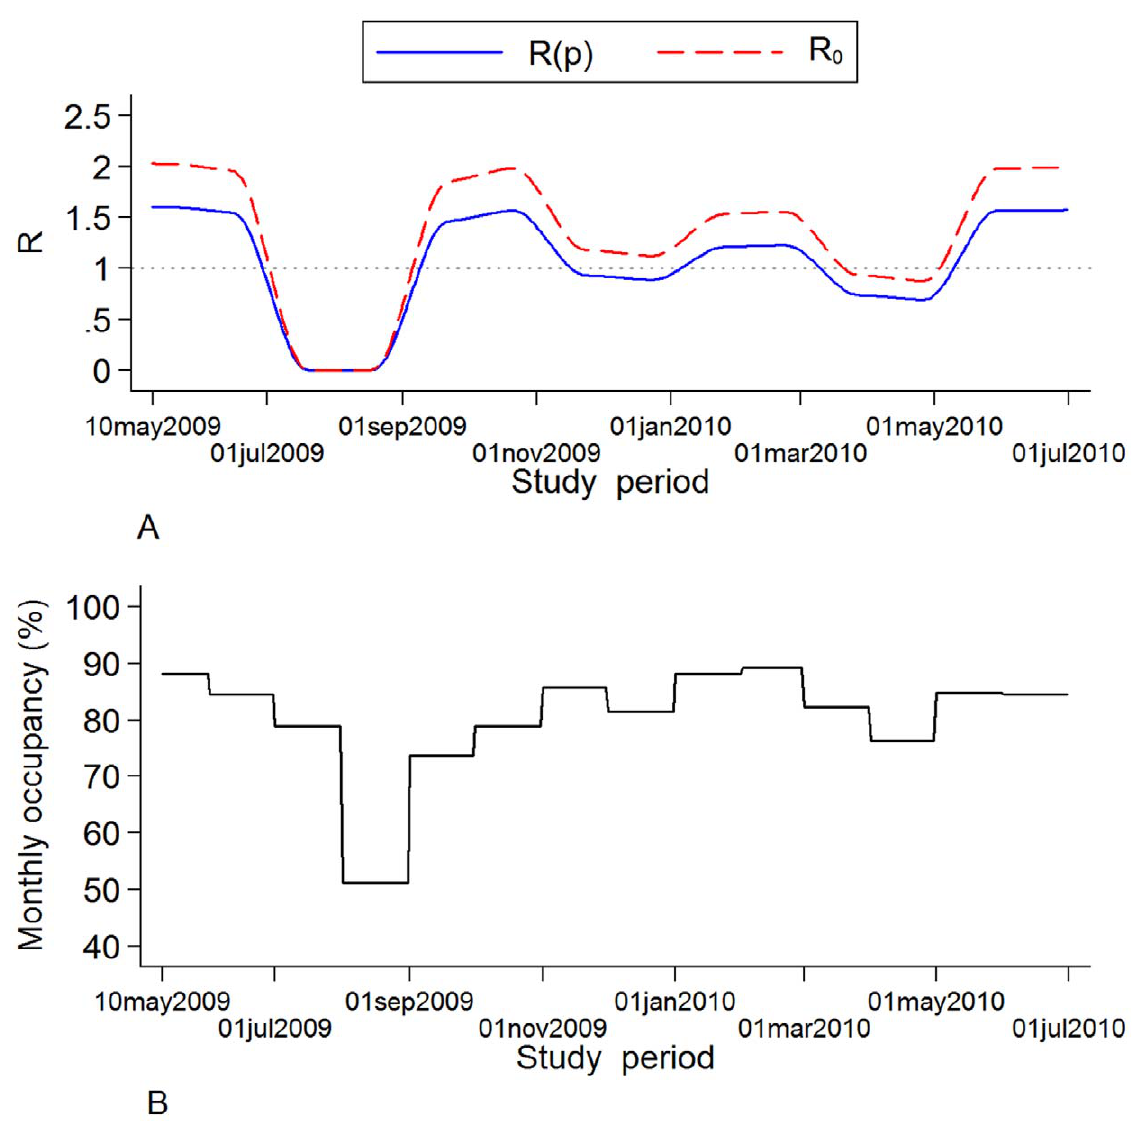
Figure 3. Bimonthly predicted effective reproduction number R(p) and observed occupancy within the surgical unit. A. Bimonthly predicted effective reproduction number R(p) (under the observed hand hygiene compliance rate of p =21% during the study period) and the corresponding basic reproduction number R 0 . Values of R(p) . 1 (dotted line) indicate the potential for an epidemic to occur. B. Observed occupancy within the surgical unit during the study period (monthly